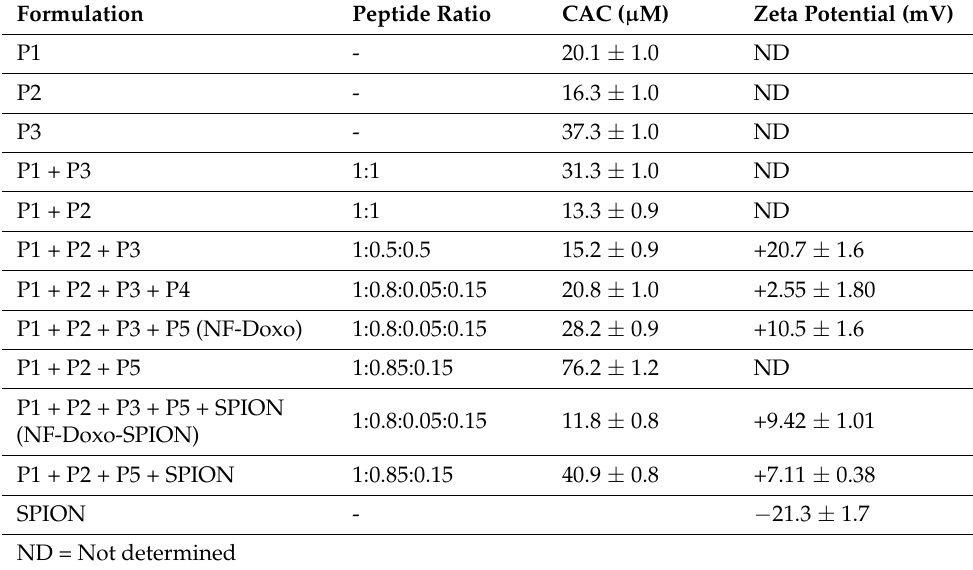
Table 2. Formulations and Critical Aggregation Concentrations